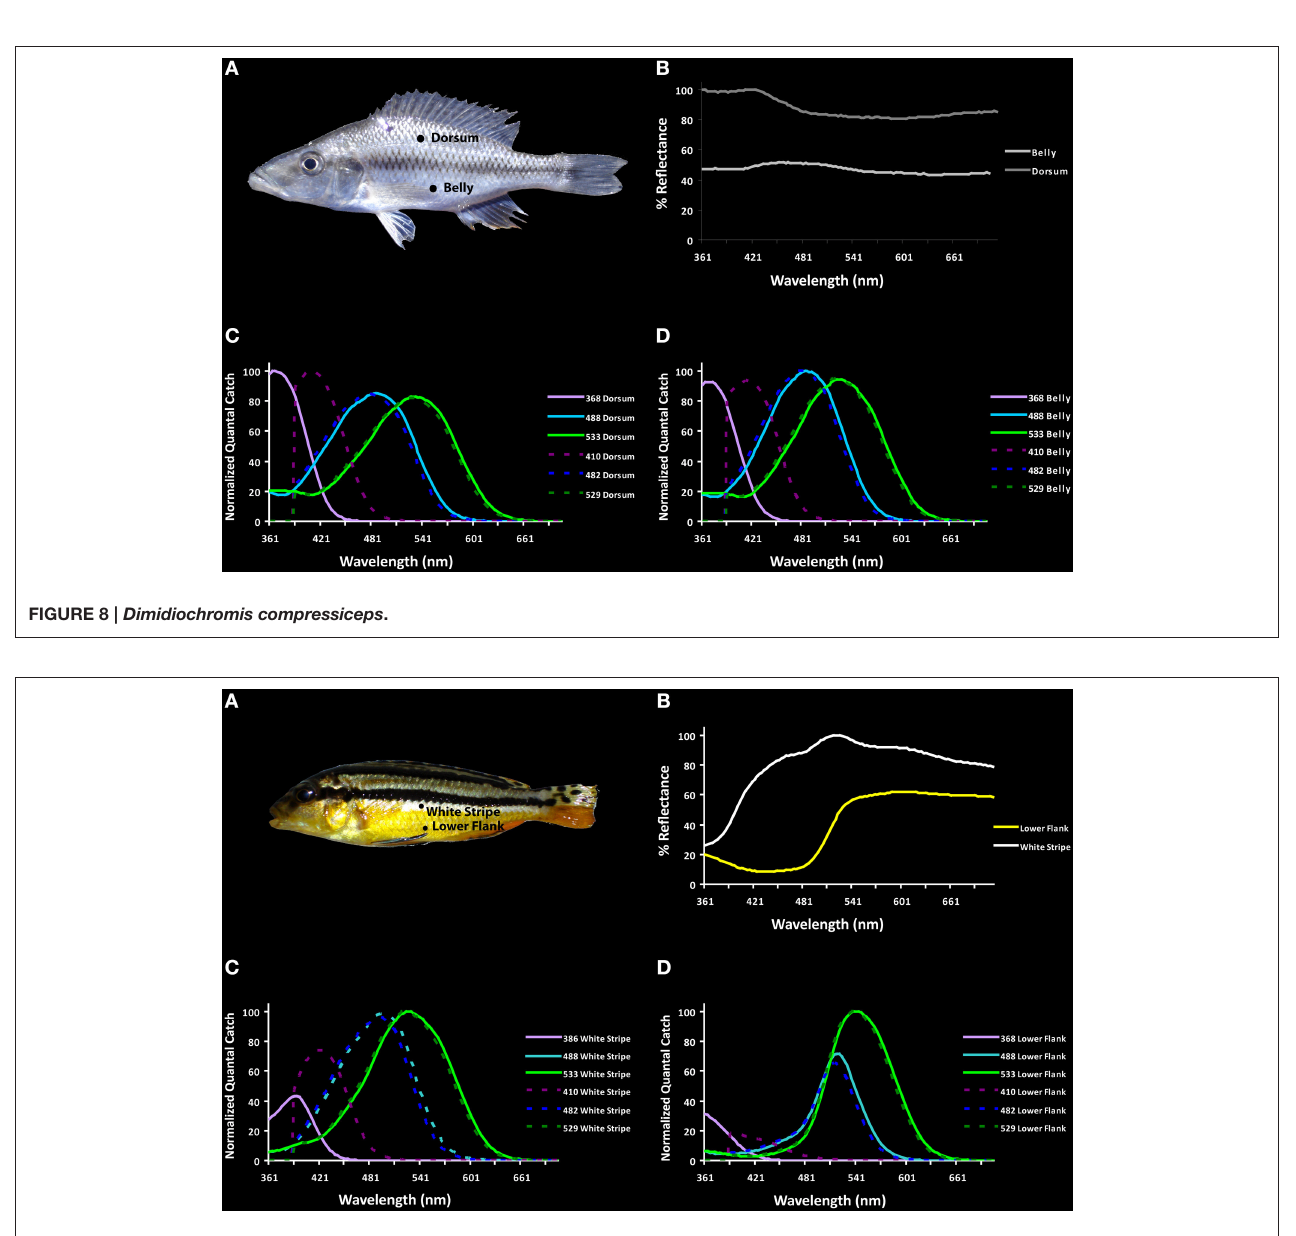
FIGURE 9 | Melanochromis auratus